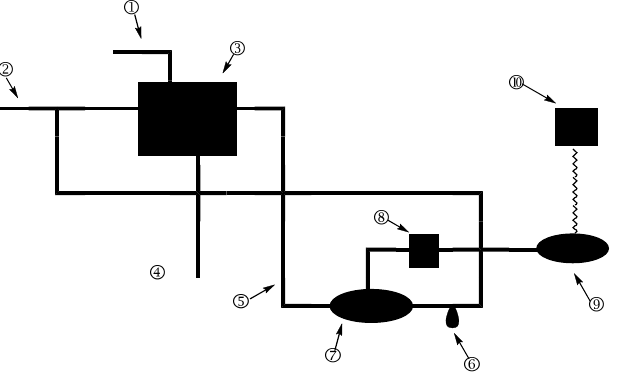
Figure 8. The structure and working diagram of the CAD [74]. ① HPLC eluent inlet. ② Nitrogen inlet. ③ Spray chamber: droplets form a spray. ④ Waste pipe: It attaches to large droplets. ⑤ Drying tube: dry particles are left after evaporation. ⑥ Corona electrodes: the gas is positively charged after ionization. ⑦ Collision cell: positive charges migrate to the surface of the particle. ⑧ Ion trap: it removes charged particles with high mobility. ⑨ Collector: the electrometer measures the surface charge. ⑩ Electrometer: signal strength is proportional to the amount of the analyte.